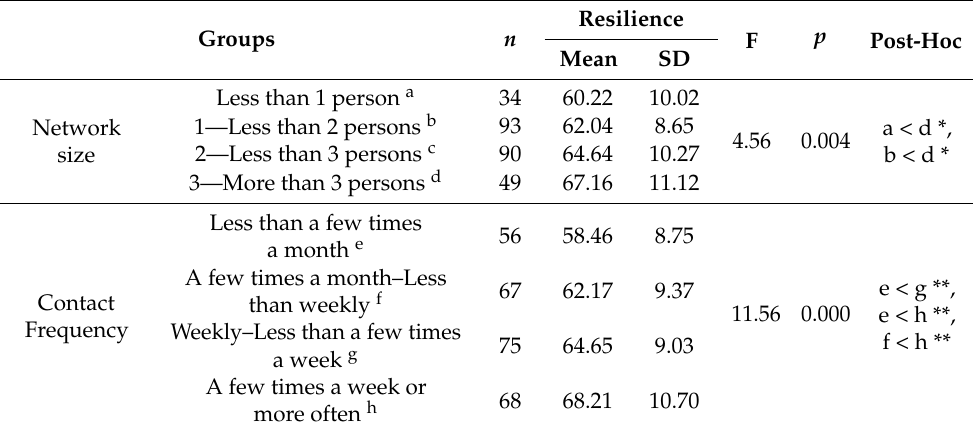
Table 3. Difference in mean scores of resilience according to social network ( n = 266). Groups